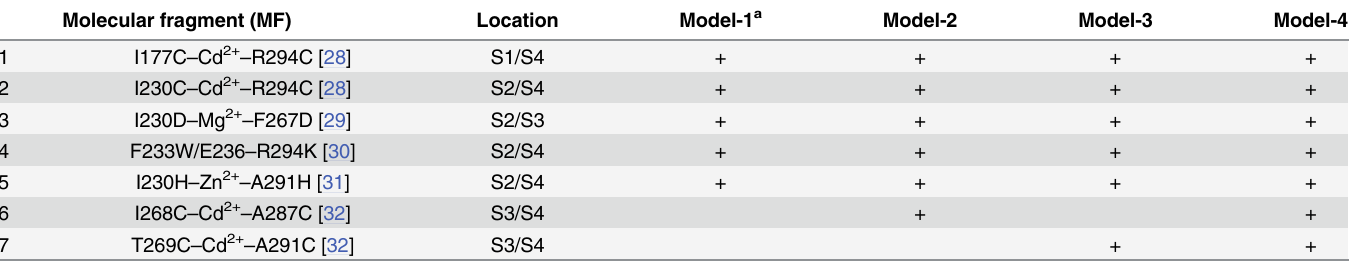
Table 1. Details of the models of the VSD of the Kv1.2 channel.